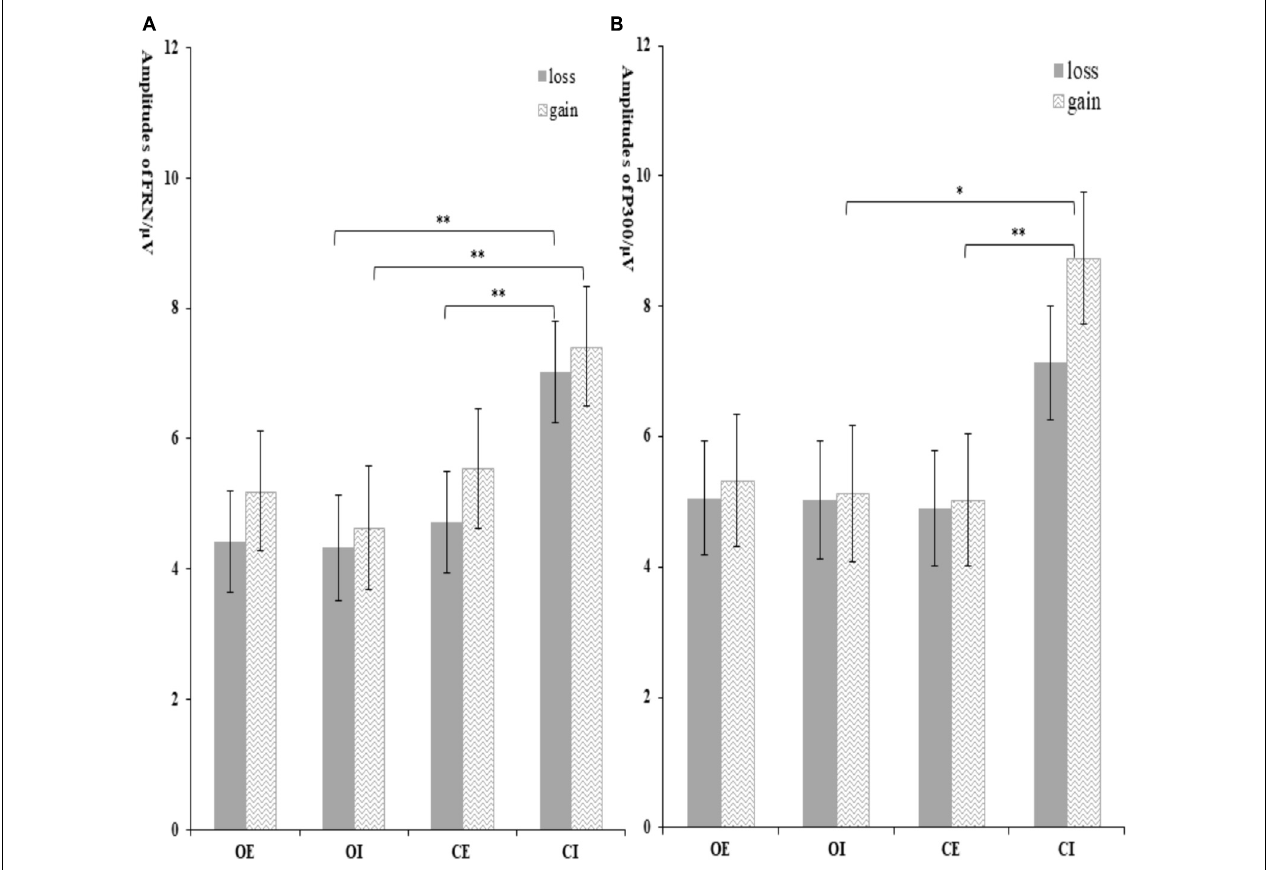
FIGURE 5 | The amplitude of FRN (A) and P300 (B) at different conditions. Error bars represent the standard errors. ∗ p < 0.05 and ∗∗ p <